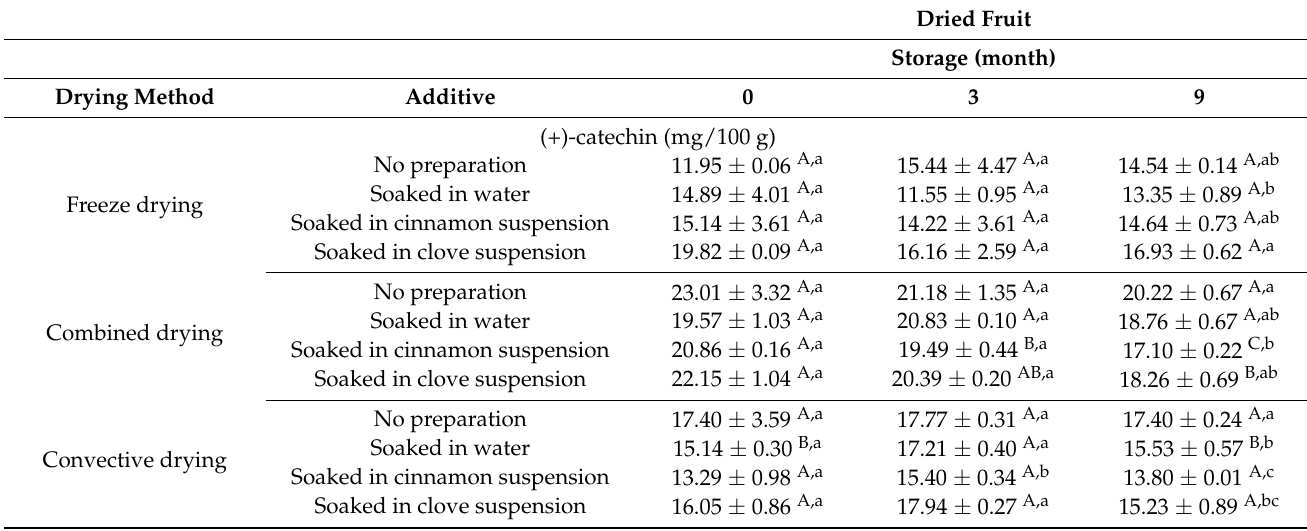
Table 3. Changes in flavanols content during storage of tested black chokeberry